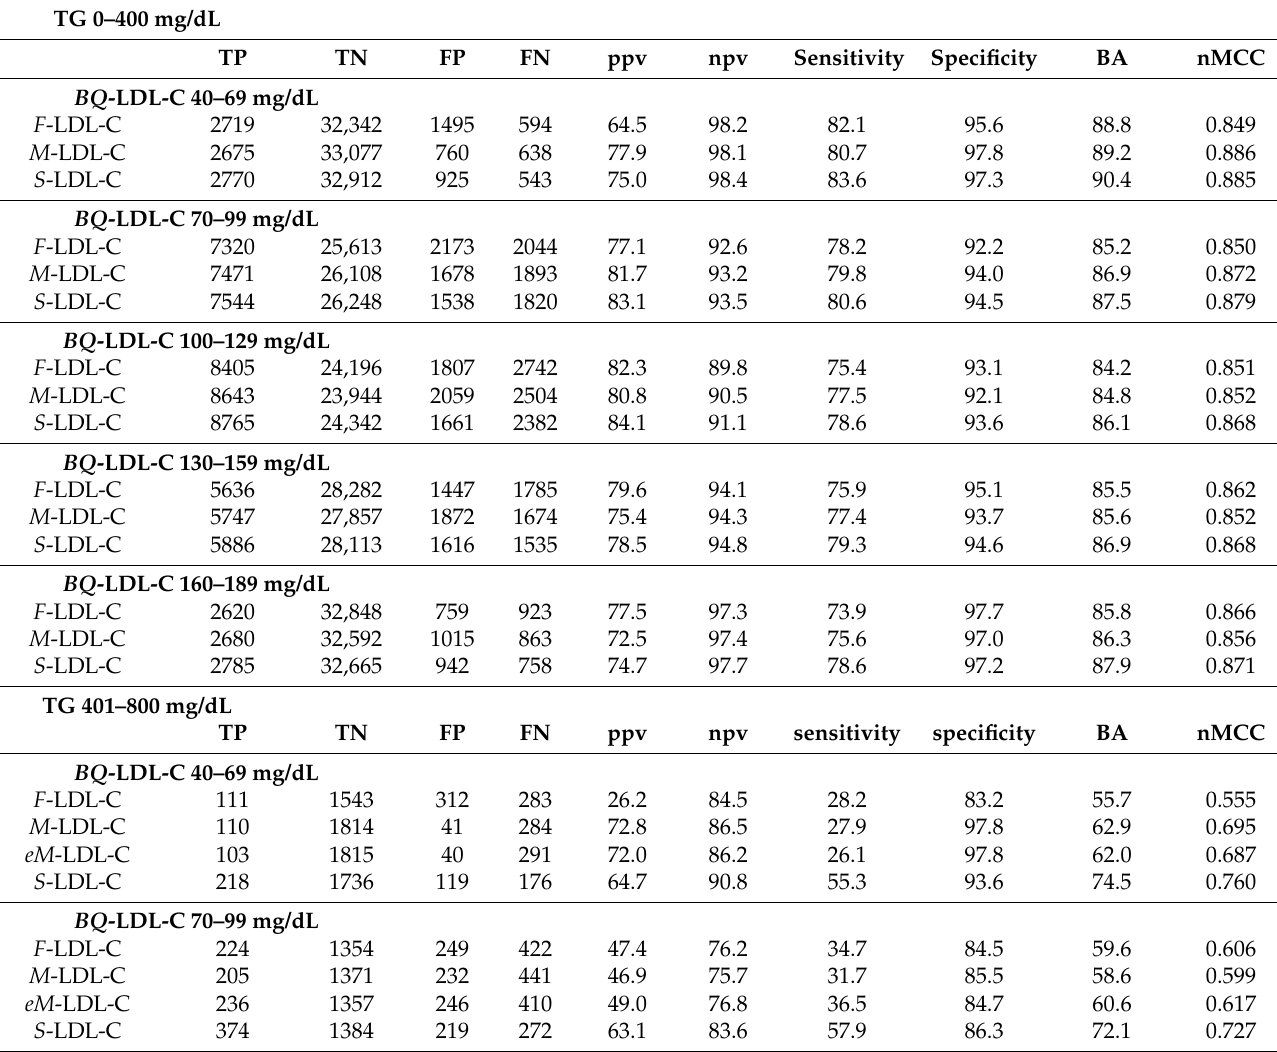
Table 1. Concordance of LDL-C equations with BQ for classification into LDL-C